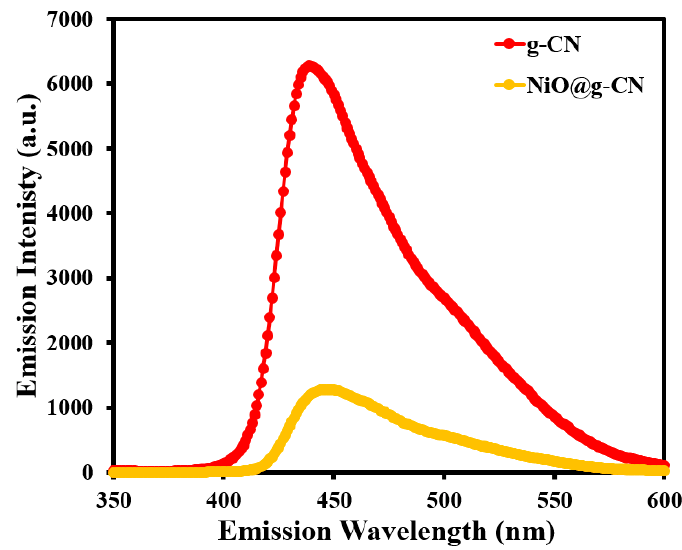
Figure 7. Photoluminescence spectra of g-CN and the NiO@g-CN nanocomposite.